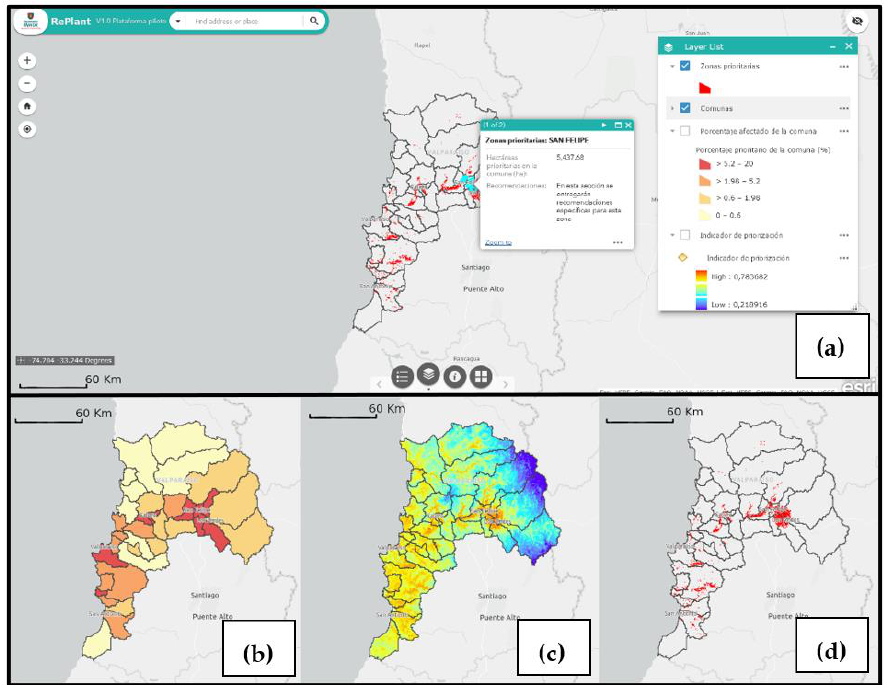
Figure 3. General view of the ” Replant alpha ” platform and the priorization results presented in the ArcGIS web map. ( a ) The platform where the results to be displayed can be manipulated, ( b ) Priority percentage of the commune (%), ( c ) prioritization index (0 to 1) and ( d ) priority restoration zones representing areas with high restoration priority